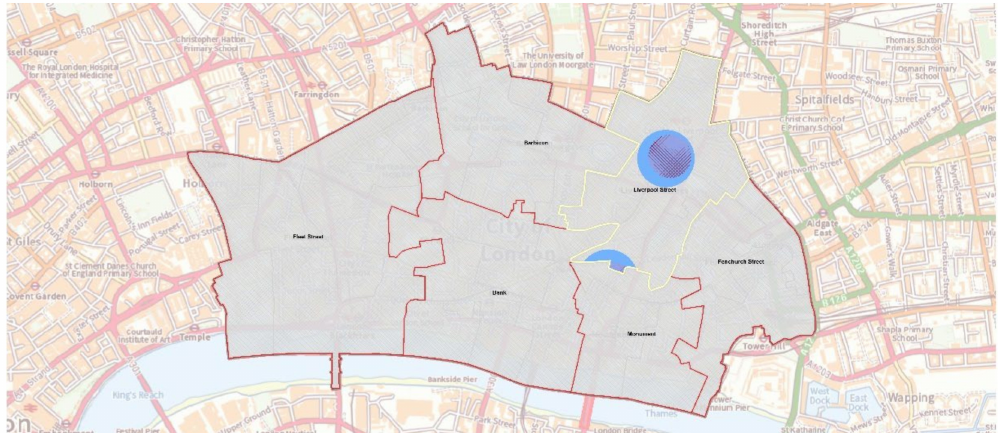
Figure 14. Shoplifting hot spots in the Liverpool Street cluster for the years 2020 (marked in blue) and 2021 (marked in red).